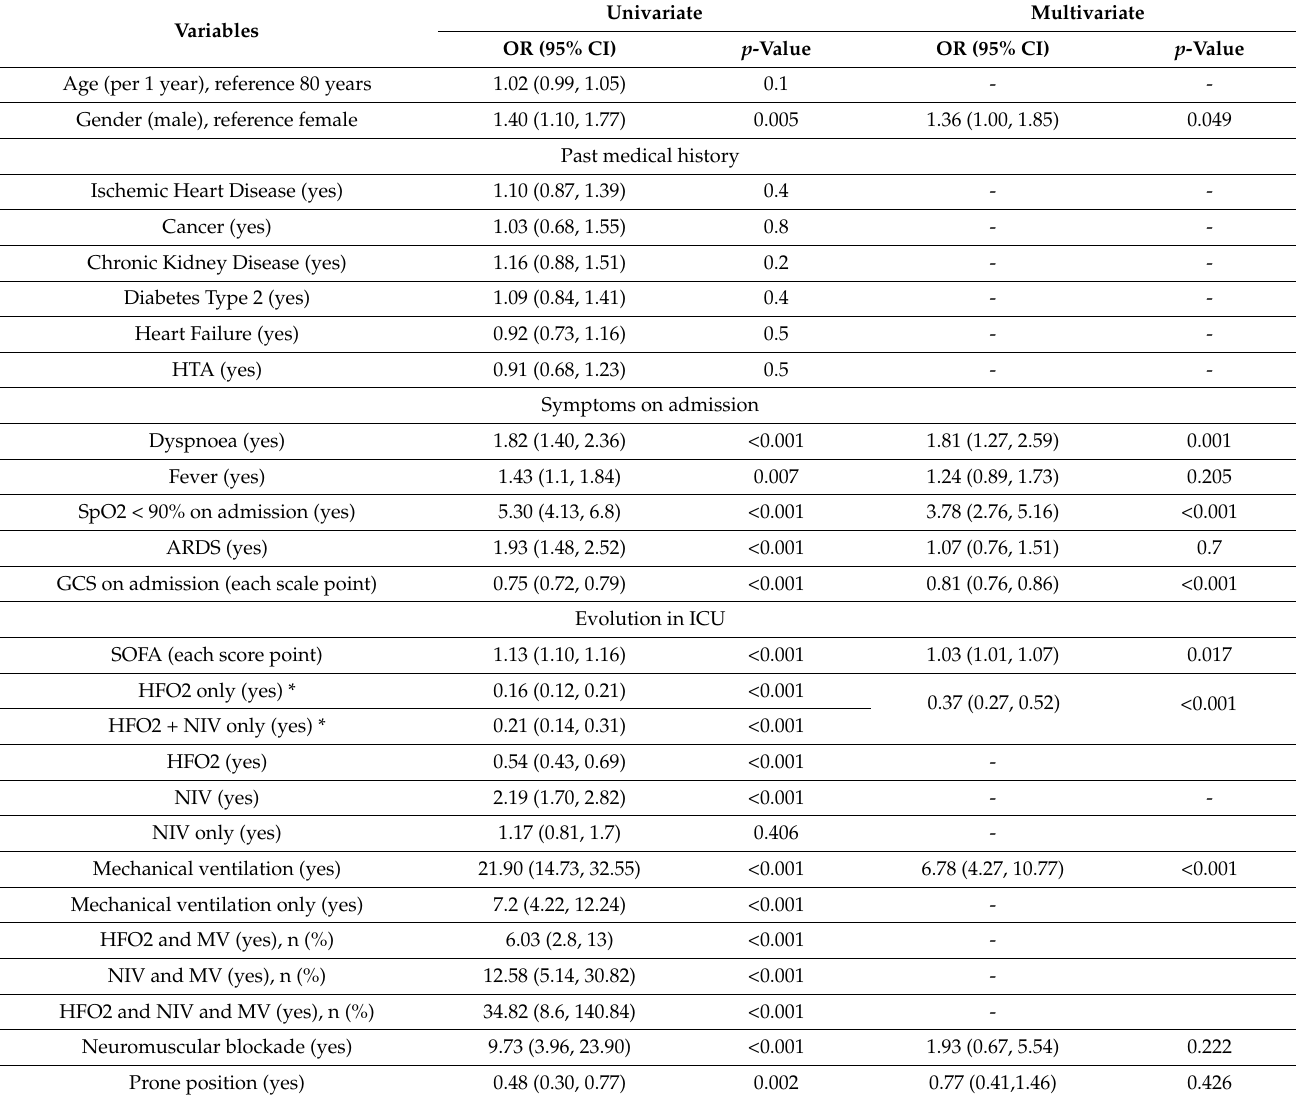
Table 3. The univariate and multivariate logistic regression analysis for ICU death as a dependent variable. Univariate Multivariate Variables OR (95% CI) p -Value OR (95% CI) p